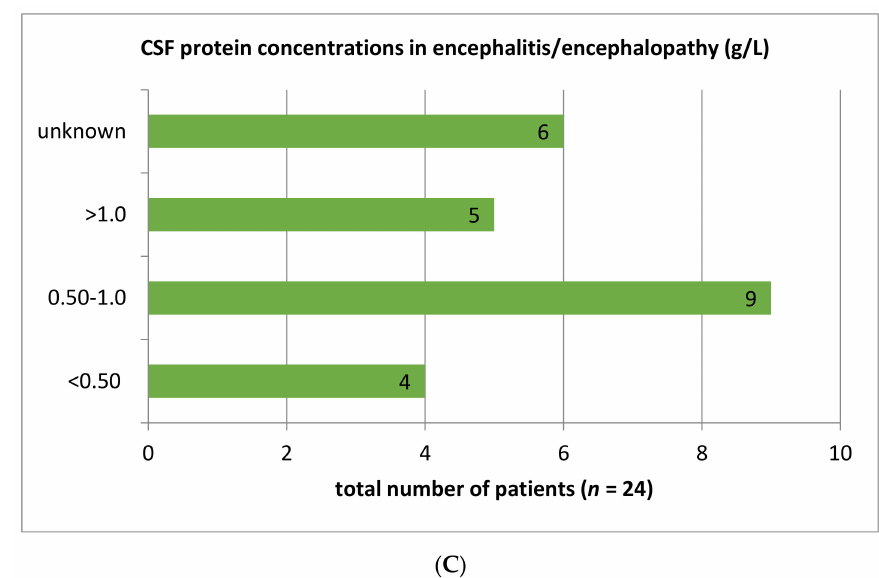
Figure 1. Number of di ff erent central nervous system manifestations in a total of 43 case reports of immune checkpoint-inhibitor (ICI)-mediated neurological adverse events ( A ). Measured cerebrospinal fluid (CSF) cell count ( B ) and protein concentrations ( C ) in the most common entity, encephalitis / encephalopathy. CSF cell count was analysed in 24 of 27 case reports with encephalitis / encephalopathy. CSF: cerebrospinal fluid; MS: Multiple sclerosis; NMOSD: Neuromyelitis optica spectrum disorder; PRES: Posterior reversible encephalopathy syndrome. Others*: Meningitis (2 cases), neurosarcoidosis (1 case), meningo-radiculo-neuritis (1 case), cerebral vasculitis (1 case), PML (1 case), central facial palsy (1 case), and brain lesion mimicking brain abscess (1